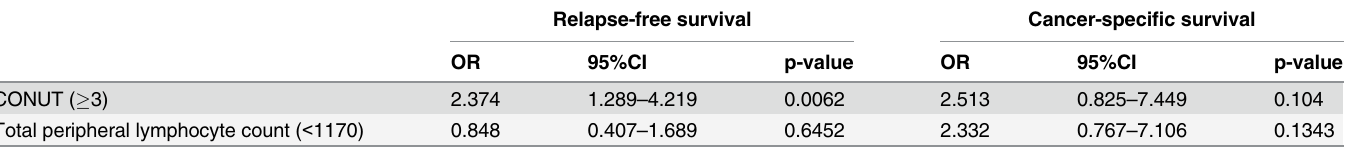
Table 9. The results of the multivariate analysis of the association between the CONUT score and the total peripheral lymphocyte count with relapse-free survival and the cancer-specific